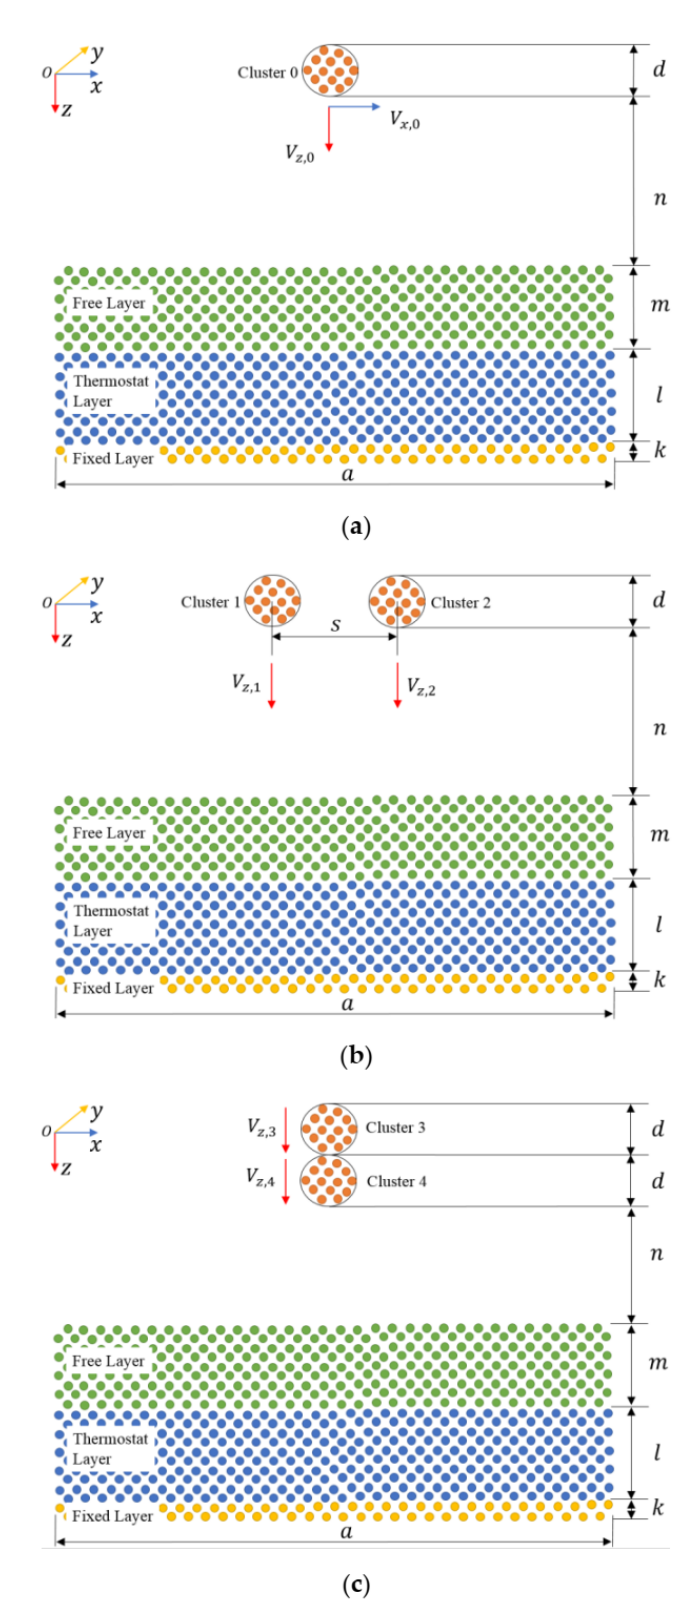
Figure 1. Cross-sectional views of 3D models in the x–z plane: ( a ) Model 1, one single cluster; ( b ) Model 2, two horizontal clusters; and ( c ) Model 3, two vertical